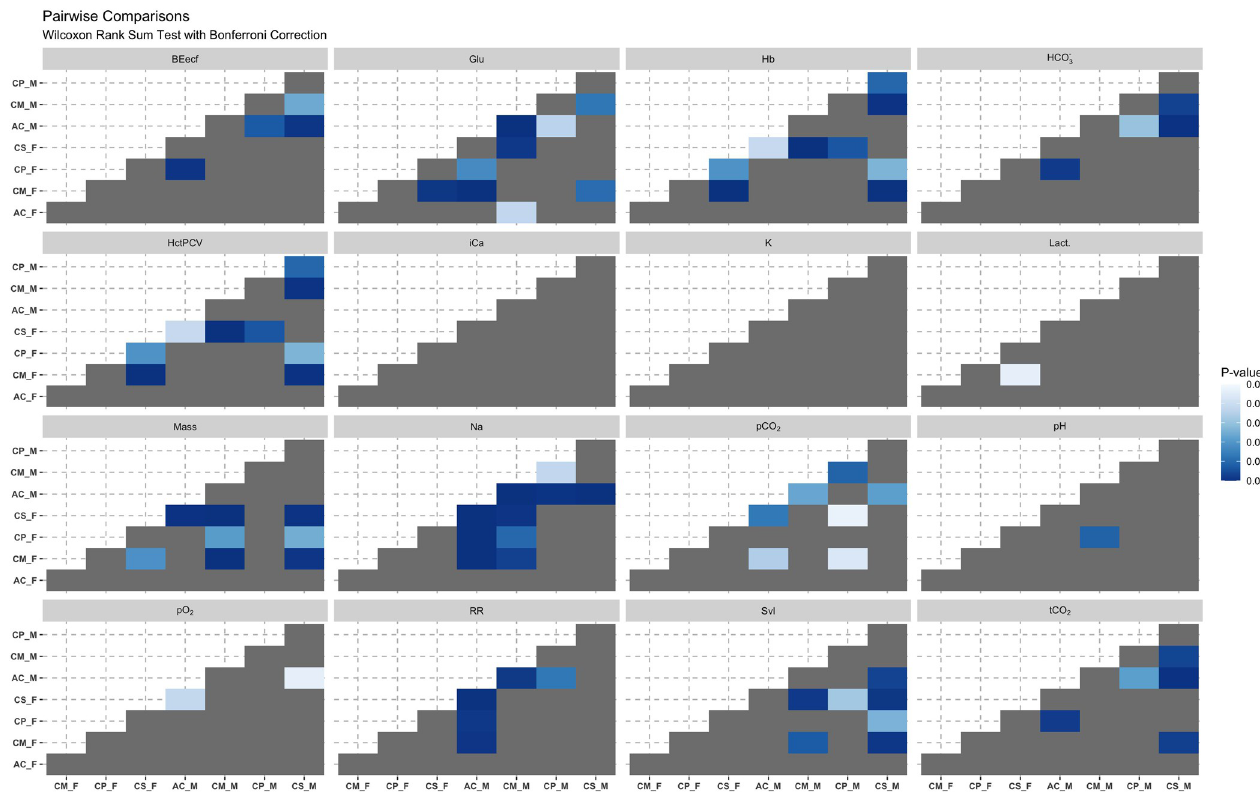
Fig 4. Pairwise comparisons. This figure shows the results Wilcoxon Rank Sum test pairwise comparisons between samples grouped based on species and sex. Darker shades of blue color indicate highly significant differences. Level of significance in pairwise tests has been adjusted using Bonferroni correction.